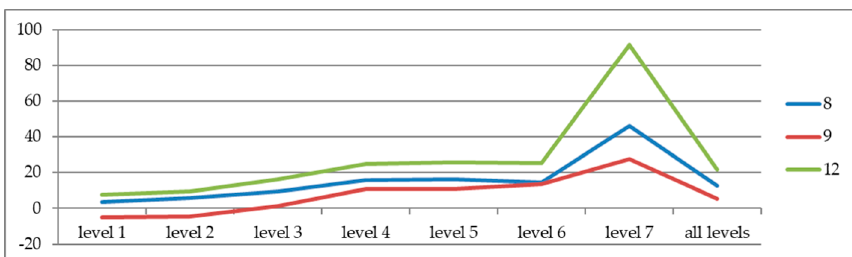
Figure 7. Line plots of relative percentage improvement concerning only nadir data (four bands) obtained for every disaggregation level.